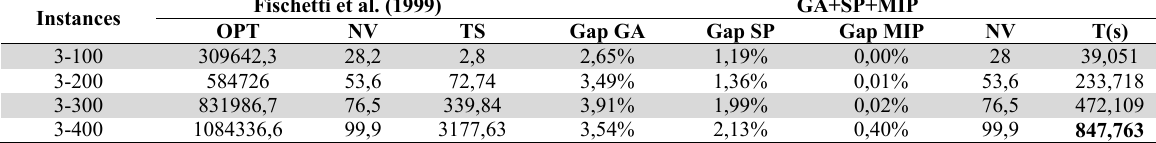
Aggregate results for the benchmark instances with 3 depots Fischetti et al. (1999) Instances